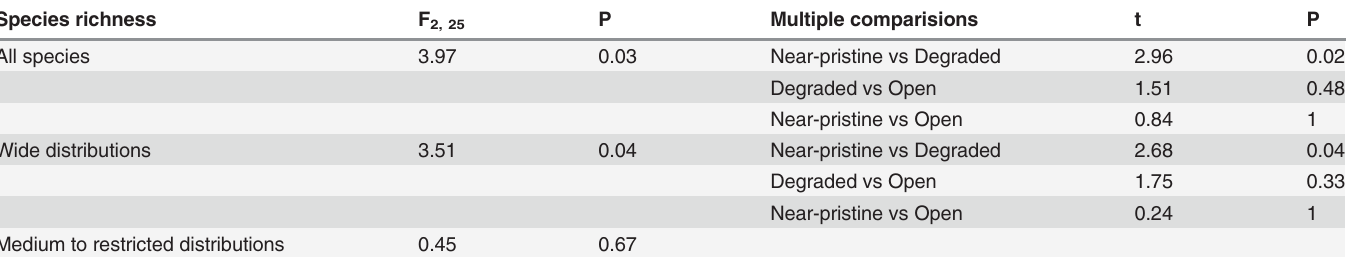
Medium to restricted